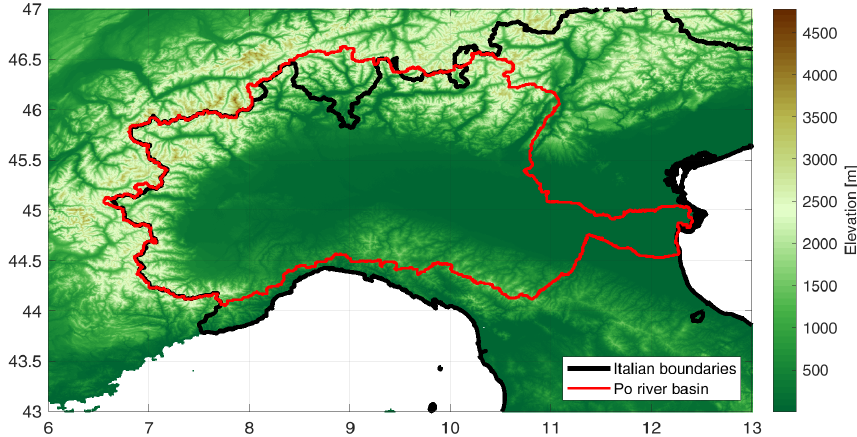
Figure 1. Po River basin elevation map from ASTGTM. The black line indicates the Italian boundaries, while the red line indicates the Po River basin